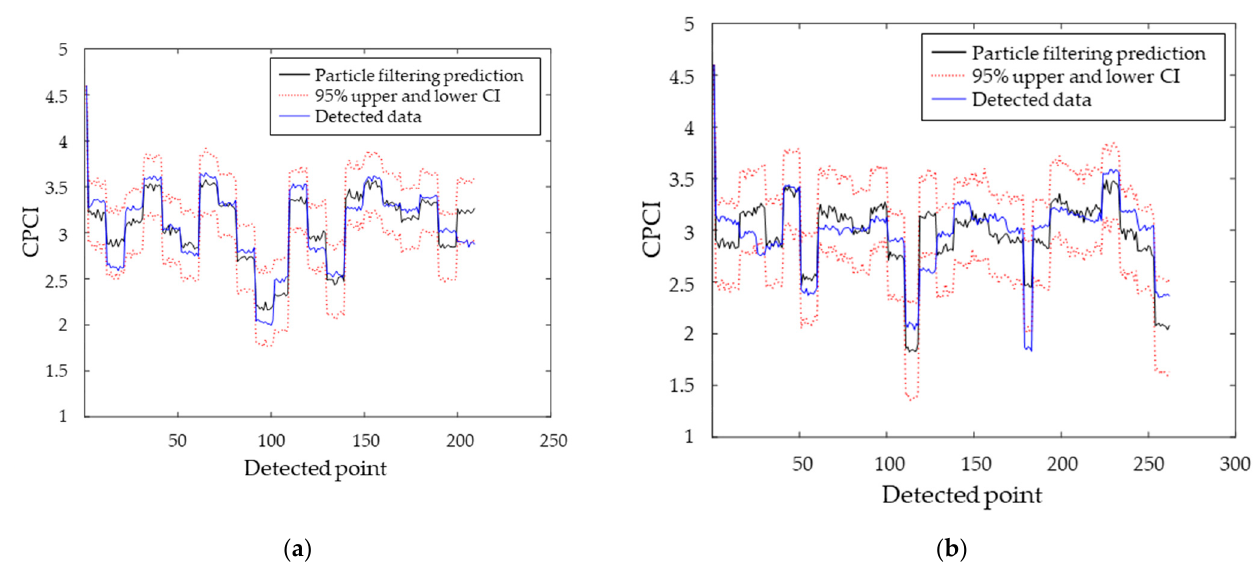
Figure 5. Particle filtering prediction of CPCI and 95% confidential interval by 15,000 particles. ( a ) 208 sections (2.08 km). ( b ) 261 sections (2.61 km).